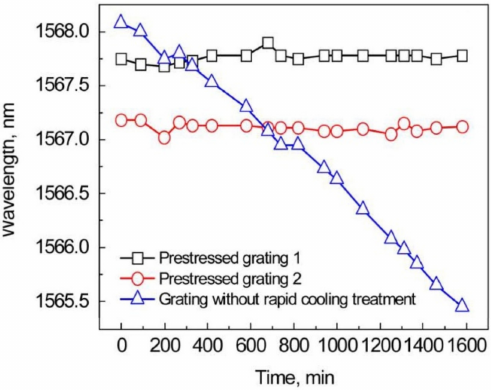
Figure 14. Bragg wavelength drift of prestressed Type II FBGs (reproduced from